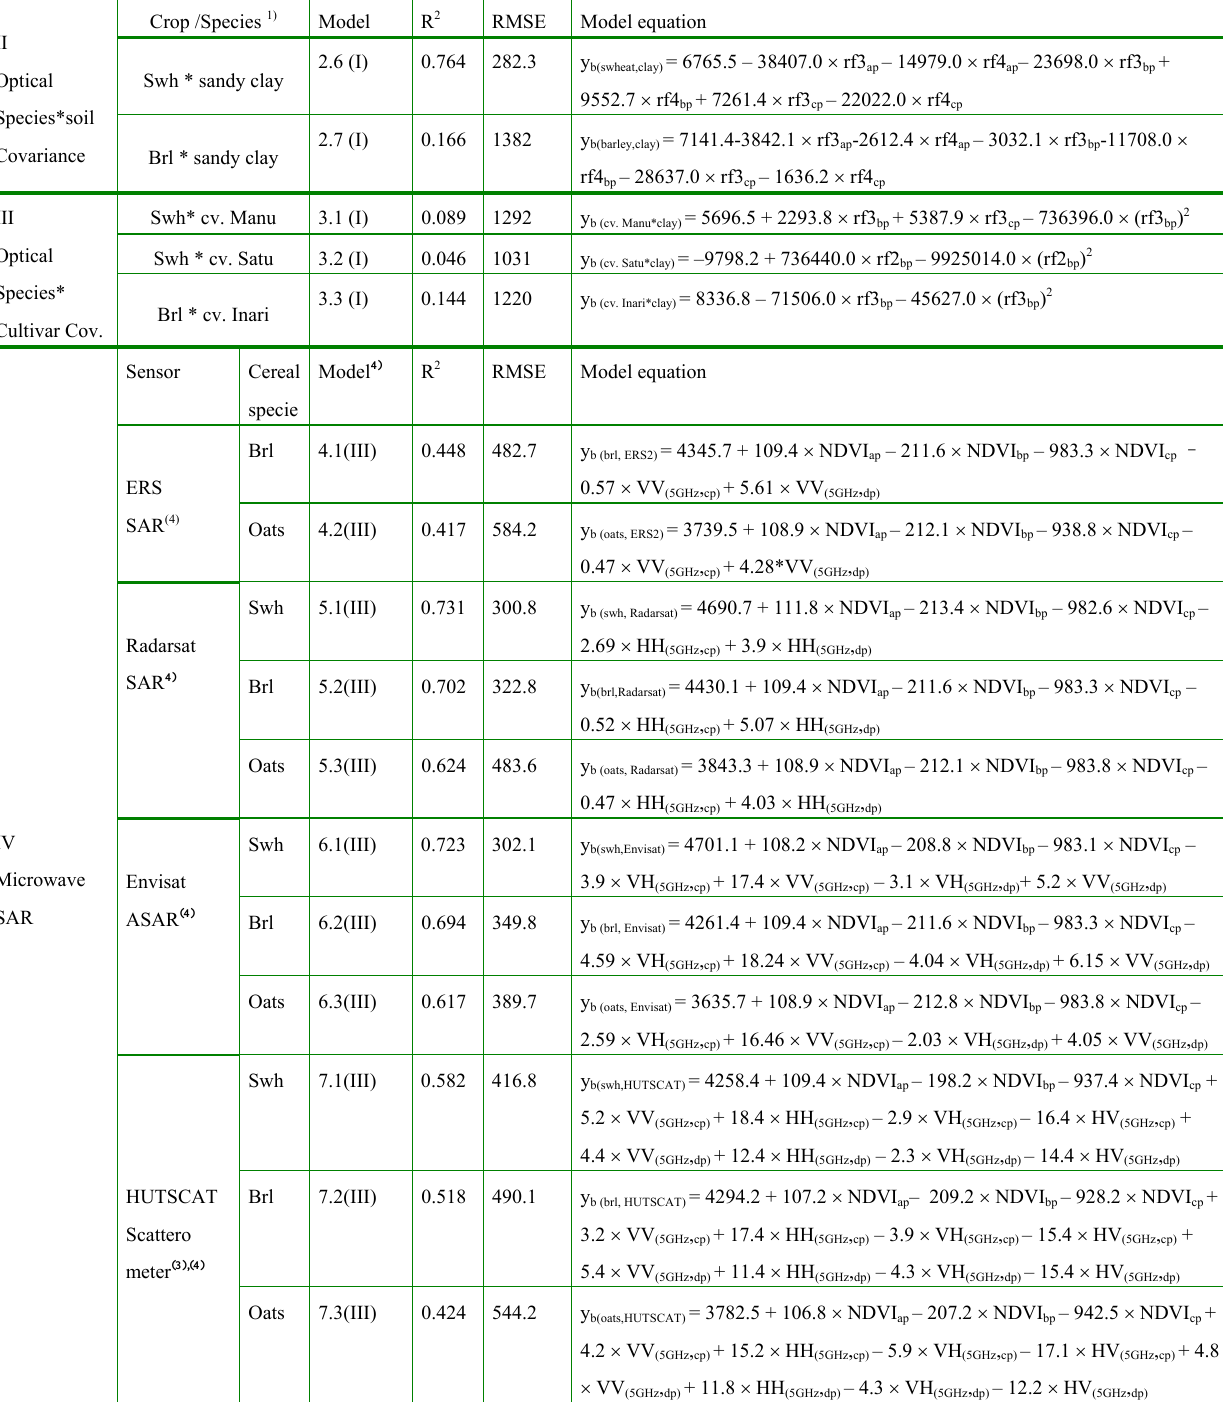
(1) For abbreviations refer to Table 9 (2) Independent variables classified with SatPhenClass-algorithm (Figure 3a,b). (3) HUTSCAT used for